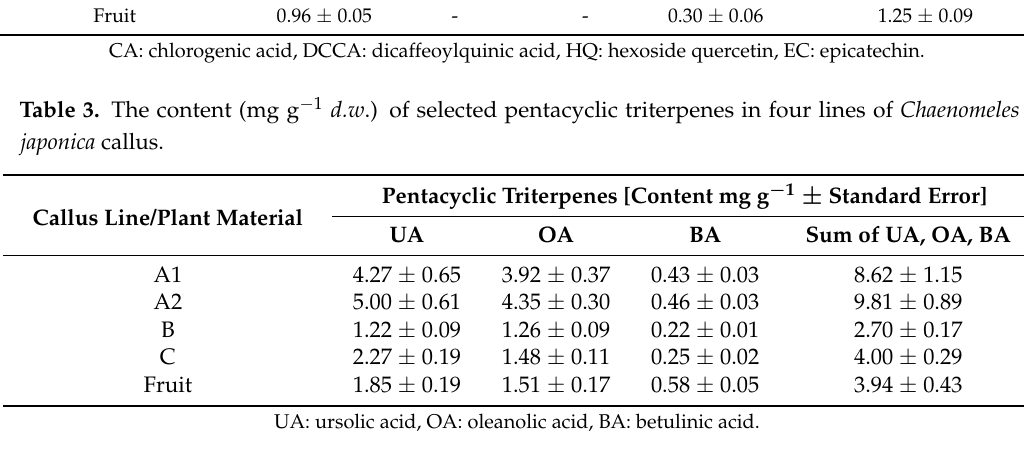
Table 4. The total content of total polyphenolics, phenolic acids, and flavonoids in four lines of Chaenomeles japonica callus.